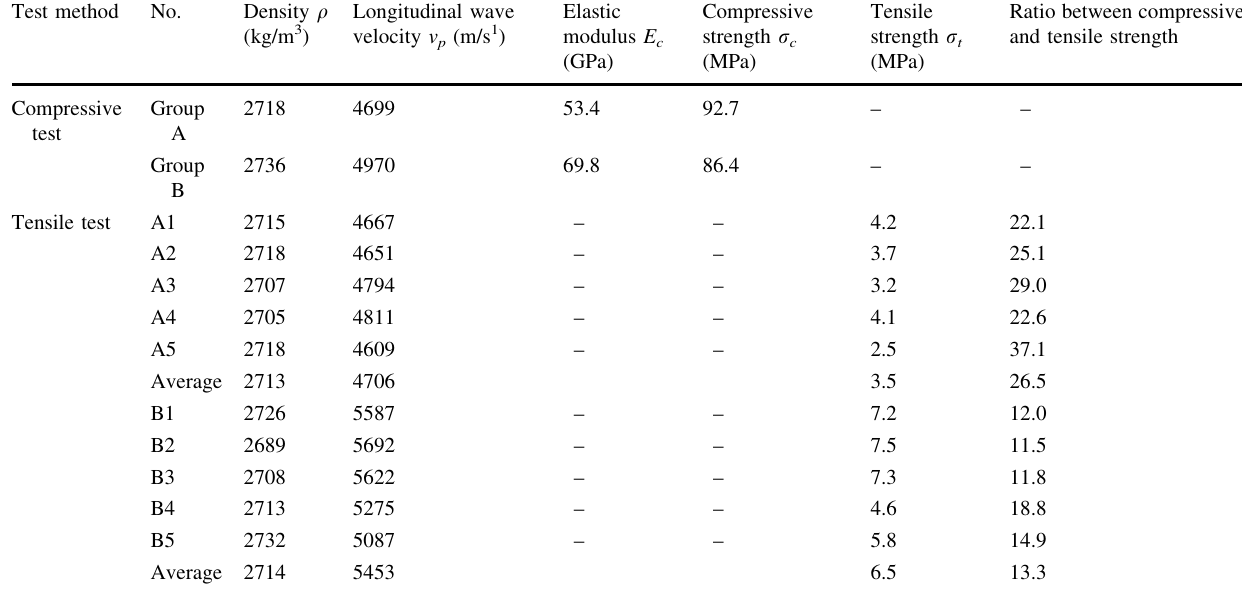
Table 1 Mechanical parameters of the two kinds of marble specimens Test method